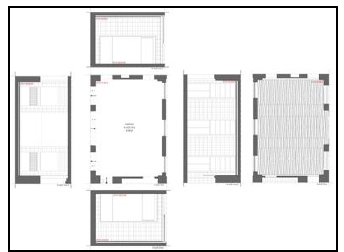
Figure 13. Example of box view of the